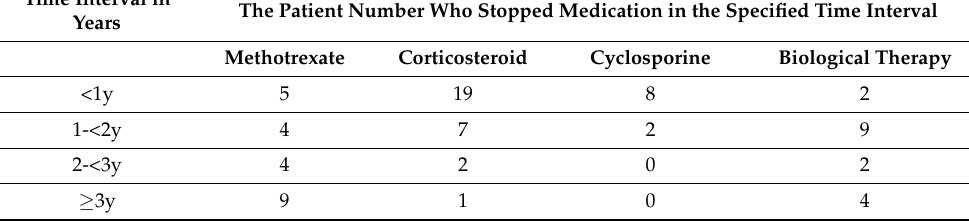
Table 5. The interval of time when specific medication was